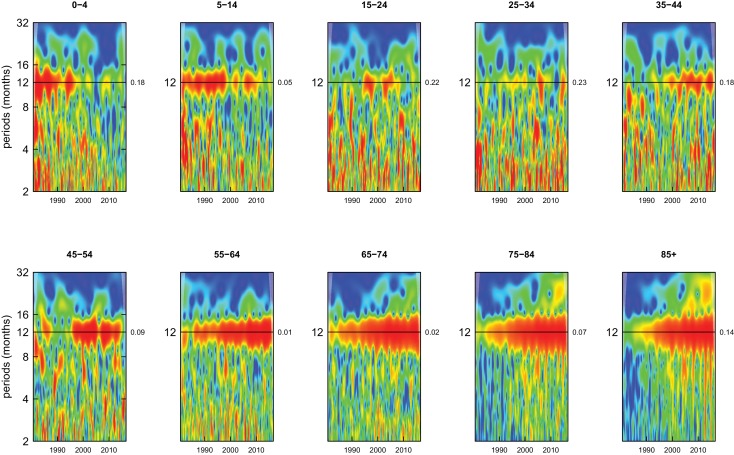
Wavelet power spectra for national time series of neuropsychiatric disorder death rates for 1980–2016, by age group for females.Wavelet power values increase from blue to red. The shaded regions at the left and right edge of each box indicate the cone of influence, where spectral analysis is less robust. P-values for the presence of 12 month seasonality are to the right of each figure at the 12 month line.